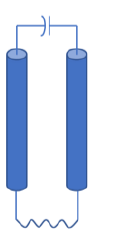
Figure 1. Equivalent model of quarter-wavelength coaxial resonant cavity.